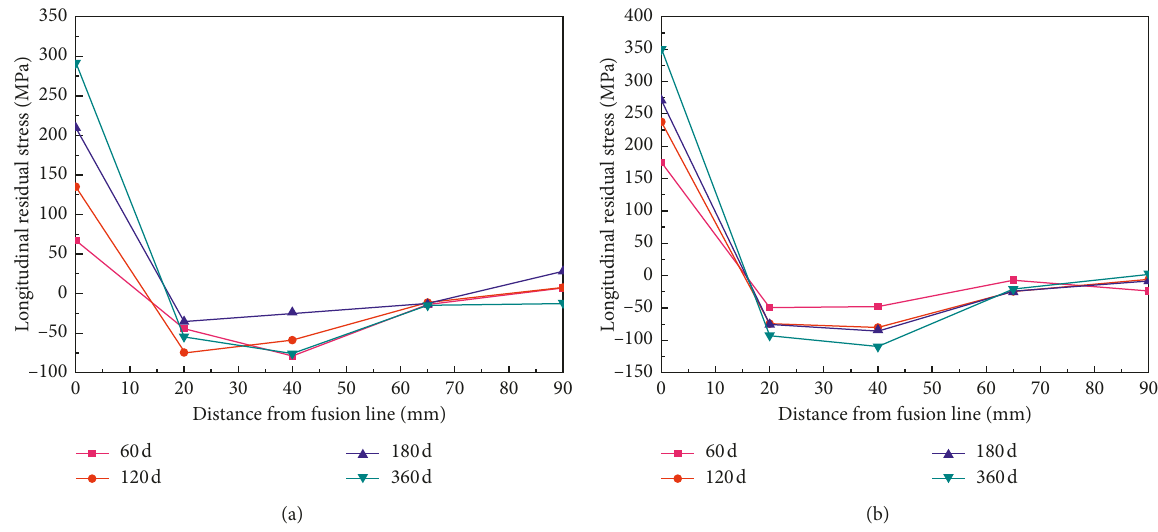
Figure 8: Evolution law of longitudinal residual stress distribution. (a) Welded structure processed by VSR. (b) Welded structure un- processed by